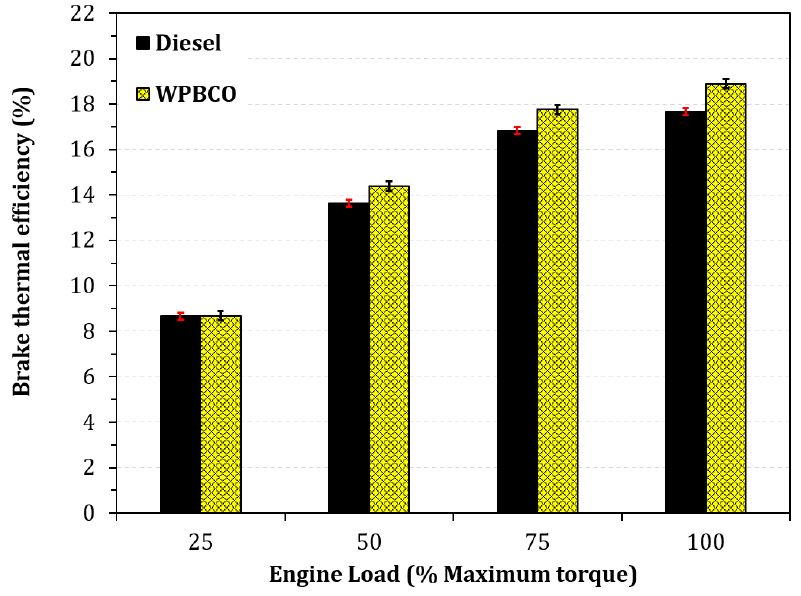
Figure 6. Variation of brake thermal efficiency with respect to engine load.